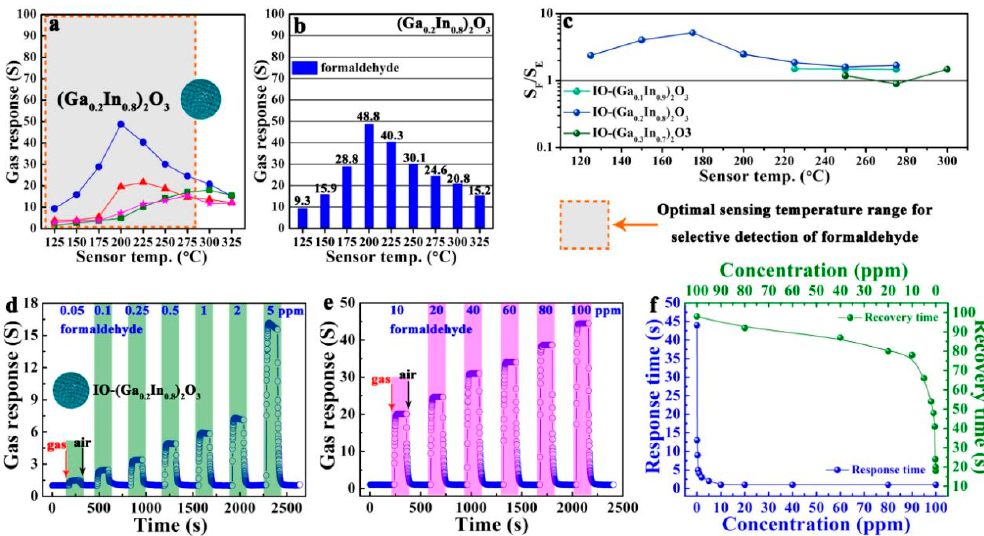
Figure 2. Gas responses (S) of the ( a , b ) IO-(Ga 0.2 In 0.8 ) 2 O 3 sensor to 100 ppm of various gases at 125– 325 ° C. ( c ) formaldehyde selectivity (S formaldehyde /S ethanol , S F /S E ) of the IO-(Ga 0.2 In 0.8 ) 2 O 3 sensor at 125– 325 ° C. Formaldehyde-sensing characteristics of the IO-(Ga 0.2 In 0.8 ) 2 O 3 sensor at 200 ° C: ( d , e ) dynamic sensing transients to 0.05–100 ppm formaldehyde, and ( f ) response/recovery times toward formaldehyde in the concentration range of 0.05–100